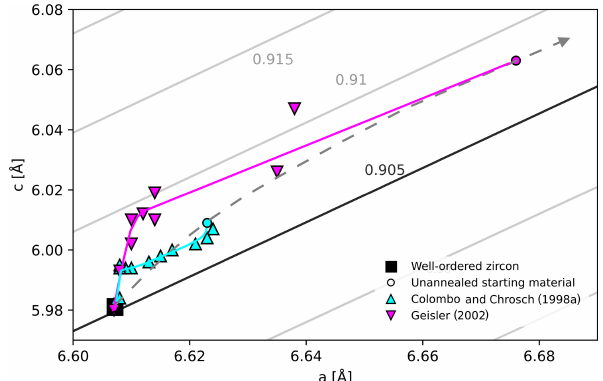
Figure B1. Zircon unit cell measurements of Colombo and Chrosch (1998a) and Geisler (2002). The colored lines are the an- nealing trajectories, starting from different damage densities. The dashed arrow is an accumulation trend based on the unannealed zir- cons. The continuous black and gray lines indicate constant c/a